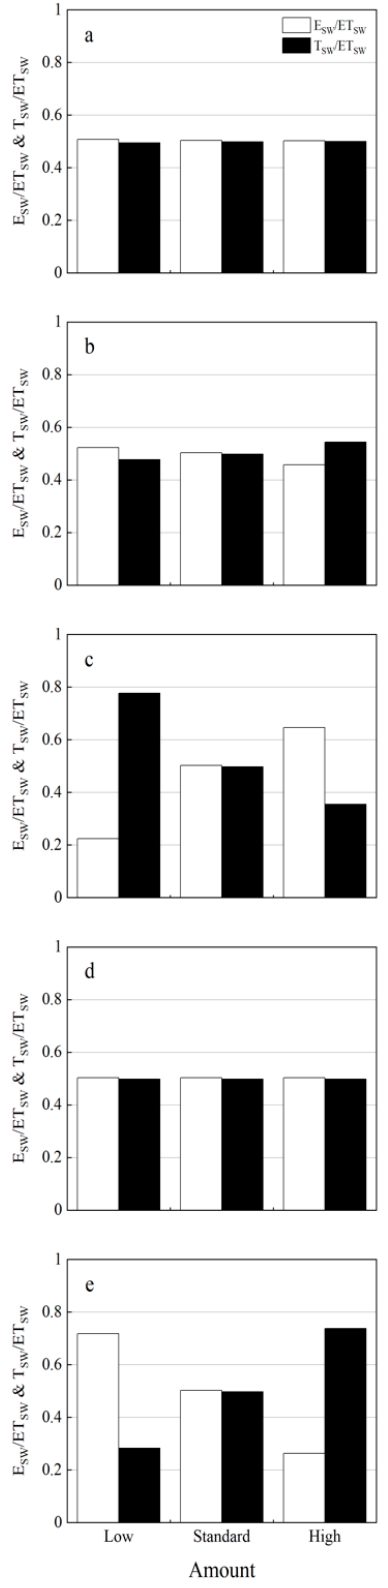
Figure 8. Effects of ( a ) net radiation, ( b ) air temperature, ( c ) 5 cm soil water content, ( d ) vapor pressure deficit, and ( e ) leaf area index on ET partitioning in the growing season of 2007 and 2008 for the degraded